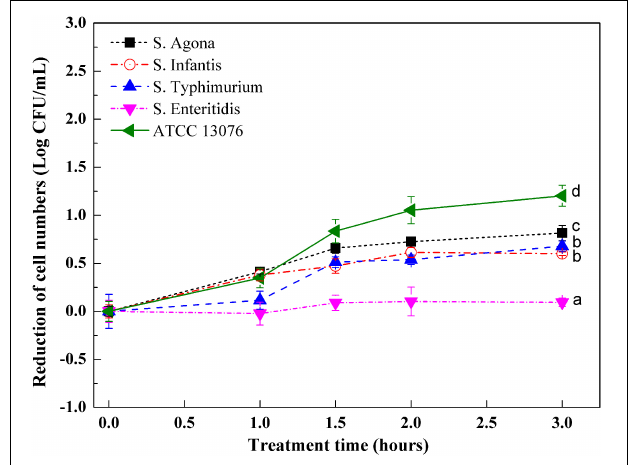
FIGURE 2 | The variation of cell numbers of five Salmonella strains when exposed to hyperosmotic stress. Each symbol indicates the mean ± standard deviation of five independent experiments ( n = 5). Different lowercase letters at treatment of 3 h indicated significant difference ( p < 0.05).